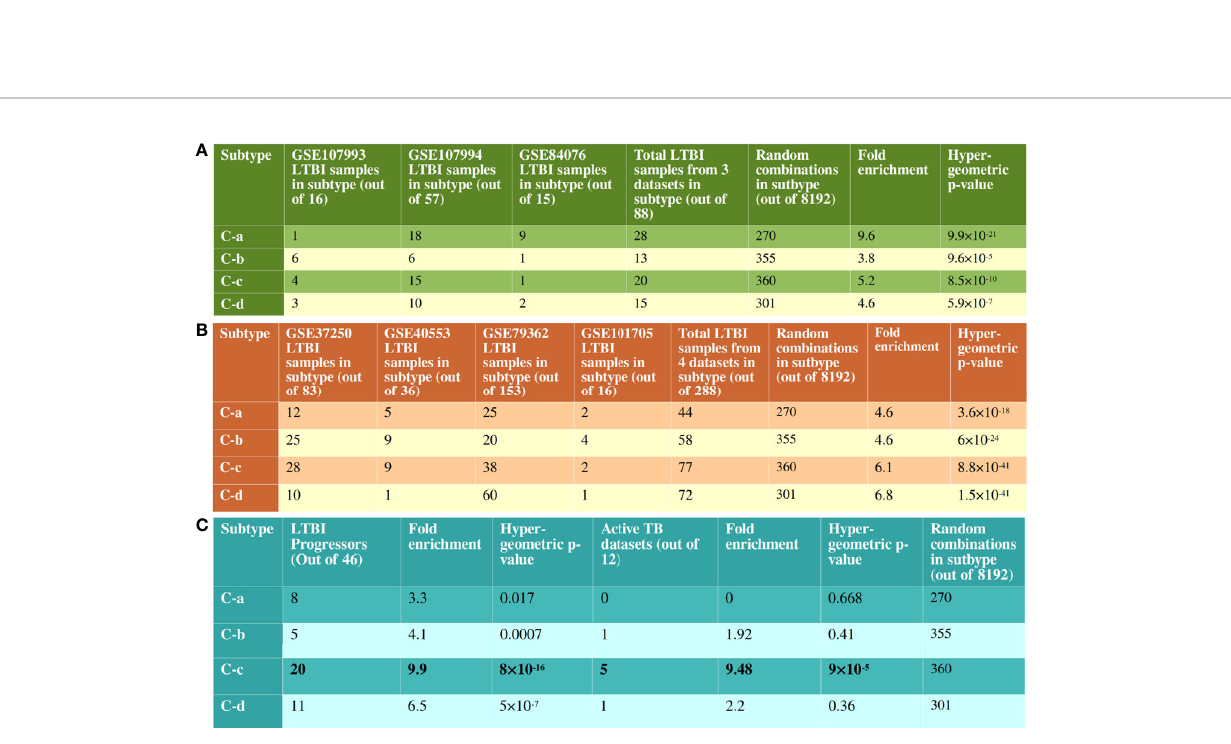
FIGURE 5 | Validation of clustering pattern with independent RNAseq datasets. (A) There are 8192 possible combinations of binary scoring patterns for the 13 pathways used for clustering analysis. 14 out of 16 samples from GSE107993, 49 out of 57 samples from GSE107994 and 13 out of 15 samples from GSE84076 clustered into one of C-a, C-b, C-c or C-d. This is signi fi cantly more enriched than the random possibilities, validating the clustering pattern of pathways. (B) Similarly, in datasets without uninfected samples, 251 out of 288 samples clustered with one of the recognized immune subtypes. Notably, in GSE79362, 153 non-progressors were analyzed and 60 of them clustered with C-d, showing a bias for non-progressor for this subtype. (C) 44 of the 46 LTBI progressor samples from GSE79362 and GSE107994 clustered one of the 4 subtypes, with a clear bias towards C-c. 5 of the 12 active TB datasets also showed immune perturbation patterns similar to the subtype